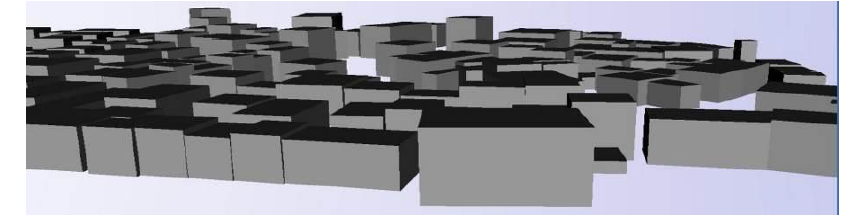
Figure 14. Block representation of 3D city models (LOD1).